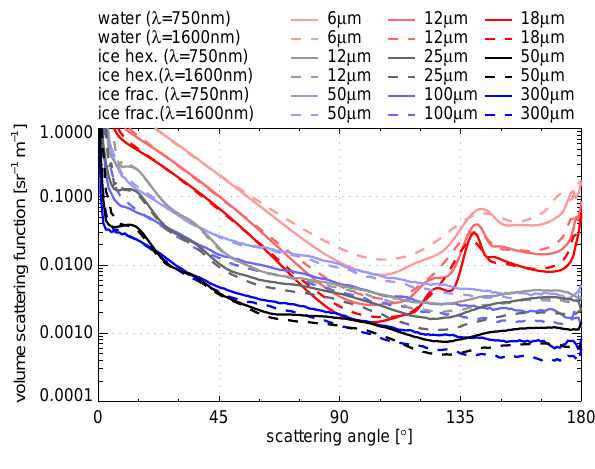
Fig. 3. Volume scattering functions of all cloud particles analyzed in Sect. 4. The dominant forward peaks is cut in this